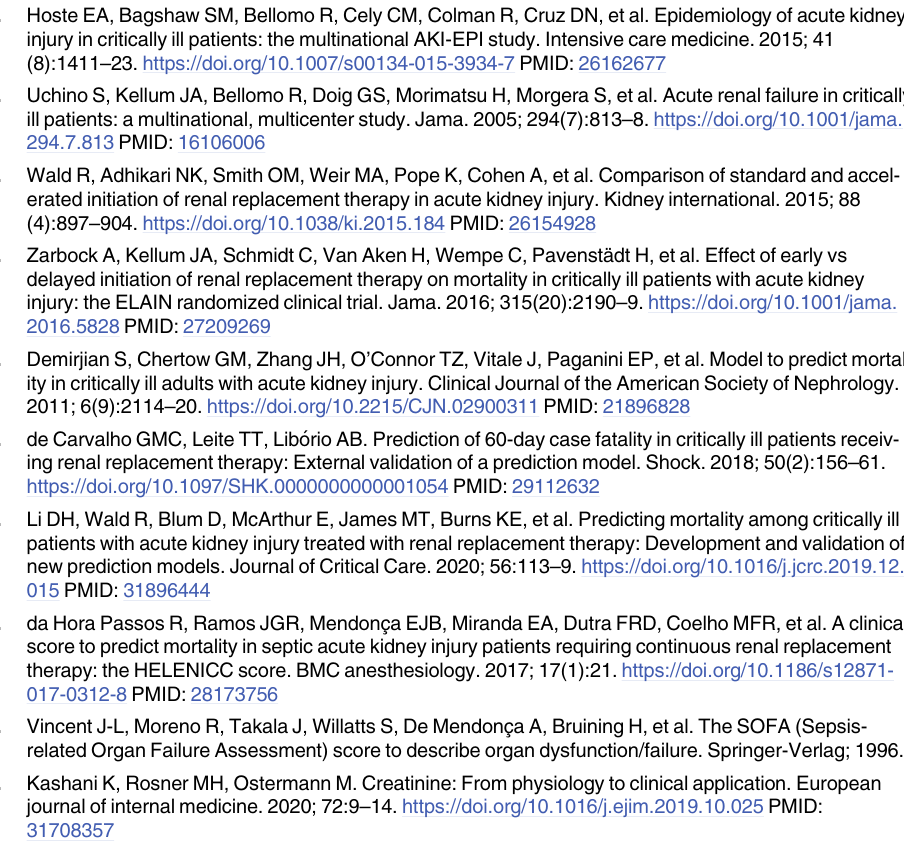
S4 Fig. Kaplan–Meier survival curve for 30-day mortality according to creatinine category in fluid-overloaded patients in the MIMIC dataset. The low-creatinine (Cr < 4 mg/dL) group was associated with worse survival (log rank test, P < 0.001). (PNG) S5 Fig. Box plot of nonrenal SOFA score between fluid-overloaded patients with low creat- inine (Cr < 4 mg/dL) and with high creatinine (Cr � 4 mg/dL) in the MIMIC dataset. The low-creatinine (Cr < 4 mg/dL) group had a higher nonrenal SOFA score ( Kruskal –Wallis test, P < 0.001).